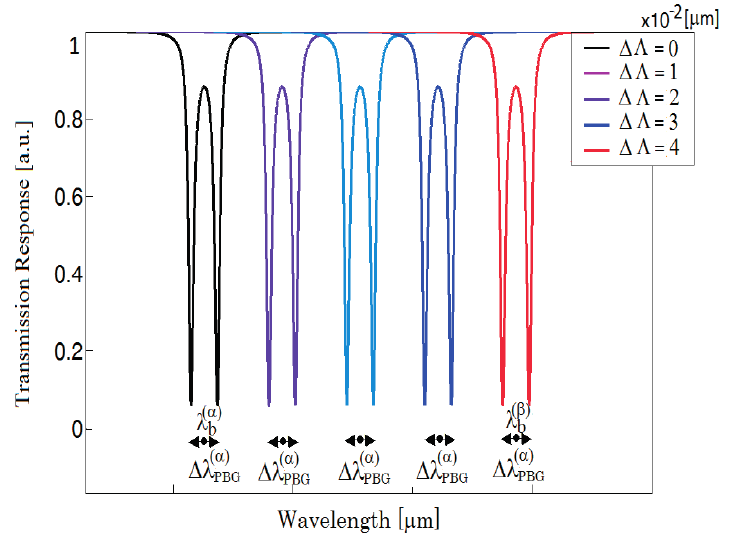
Figure 3. Bragg microcavity resonator transmission when Λ changes with Δ Λ = 1 × 10 − 2 μ